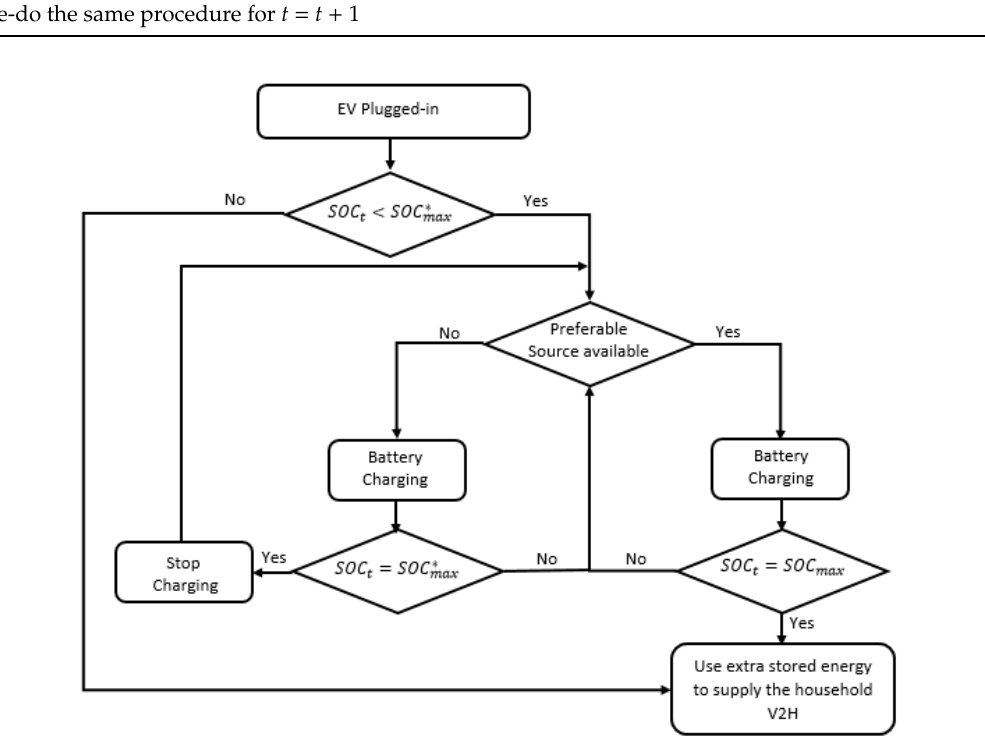
Figure 5. Scenario 1 logic diagram .